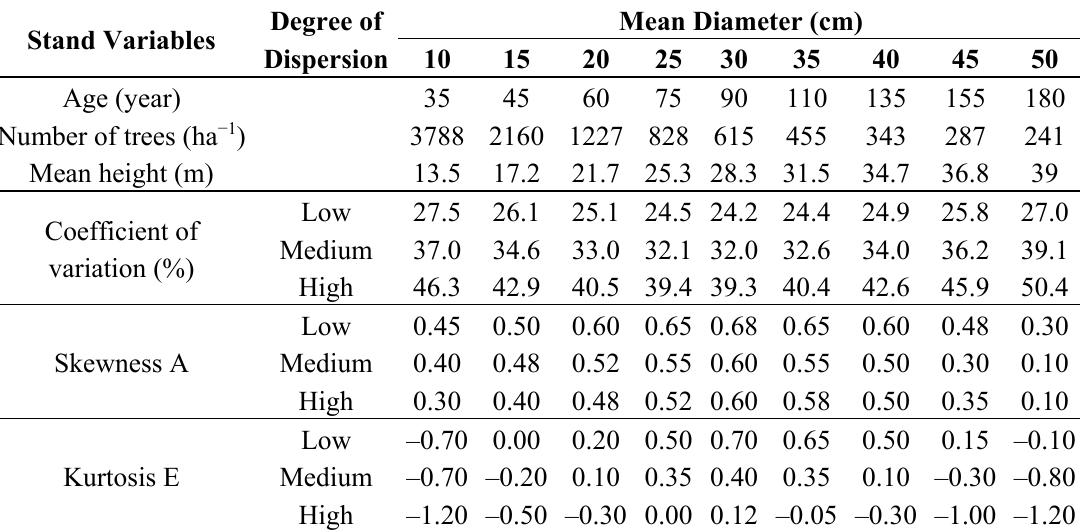
Table 3. Input variables for simulation of individual trees in virtual stands.